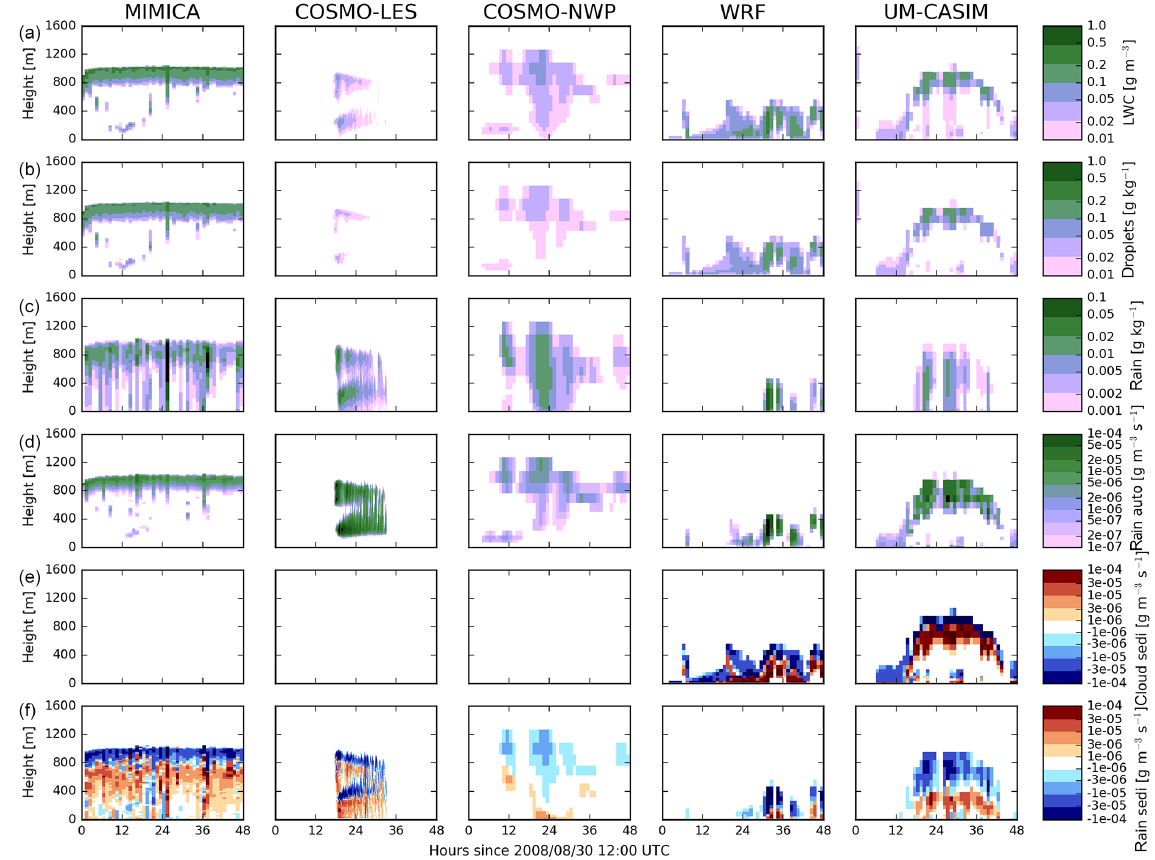
Figure 6. Liquid water contents, cloud and rain mass mixing ratios, and tendencies due to liquid-phase processes for simulations with a prescribed CDNC of 3cm − 3 and no cloud ice permitted (CDNC03_NOICE). (a) Liquid water contents. (b) Mass mixing ratios of cloud droplets. (c) Mass mixing ratios of rain. (d, e, f) Tendencies of mixing ratios of cloud droplets or rain due to (d) autoconversion of cloud droplets to rain, (e) sedimentation of cloud droplets, and (f) sedimentation of rain. Results are shown (from left to right) from the MIMICA, COSMO-LES, COSMO-NWP, WRF, and UM-CASIM models. Note that only WRF and UM-CASIM simulate the sedimentation of cloud